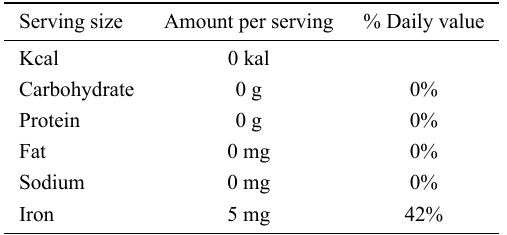
Table 1. Nutritional composition of iron